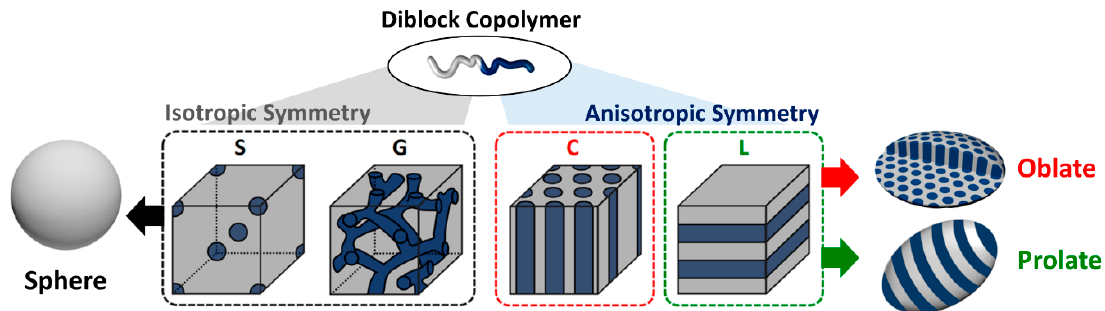
Figure 1. Schematic illustrations of the block copolymer particle (BCP) phases in bulk (S: spheres, G: gyroid, C: cylinders, and L: lamellae) and the corresponding structure of polymer particles at neutral conditions (reprinted with permission from [28], Copyright 2019, American Chemical Society).